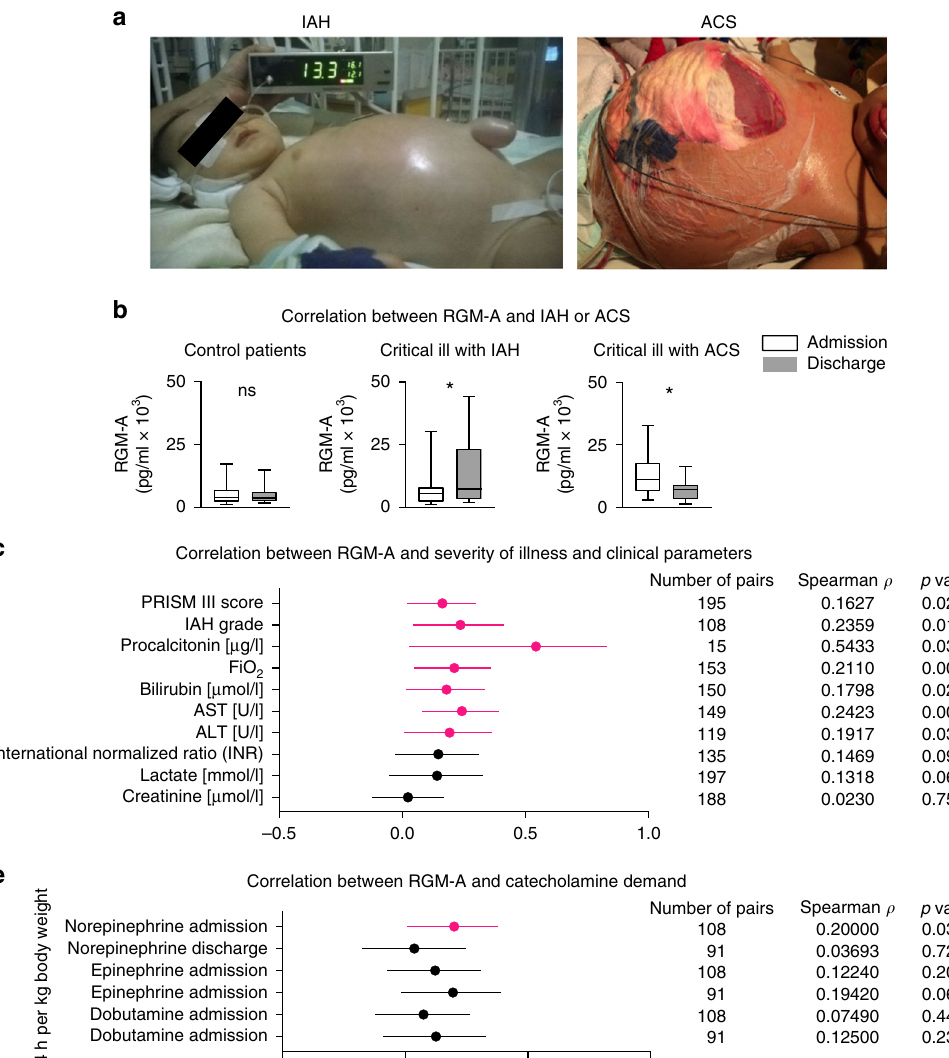
Fig. 6 RGM-A in pediatric ICU patients with abdominal compartment syndrome. Plasma samples from 109 ICU children with and without abdominal compartment syndrome (ACS) were collected within 24 h after admission to and at day of discharge from the Pediatric Intensive Care Unit (PICU) of Hannover Medical School (MHH, Germany). a Representative images displaying critical ill children with IAH (conservative therapy management) (left) and ACS (after decompressive laparotomy with the establishment of an open abdomen / laparostoma to reduce intra-abdominal pressure and the associated tissue and organ impairments) (right). Despite surgical decompression, the child from the ACS cohort died of uncontrollable multiple organ failure. b Overview of ICU patient characteristics within the control group (Prism-III-score < 8), critically ill children with IAH (IAP > 10 mmHg) but without ACS and critically ill children meeting the WSACS de fi nitions 29 for ACS. c Correlation between RGM-A and clinical parameters of all PICU patients at day